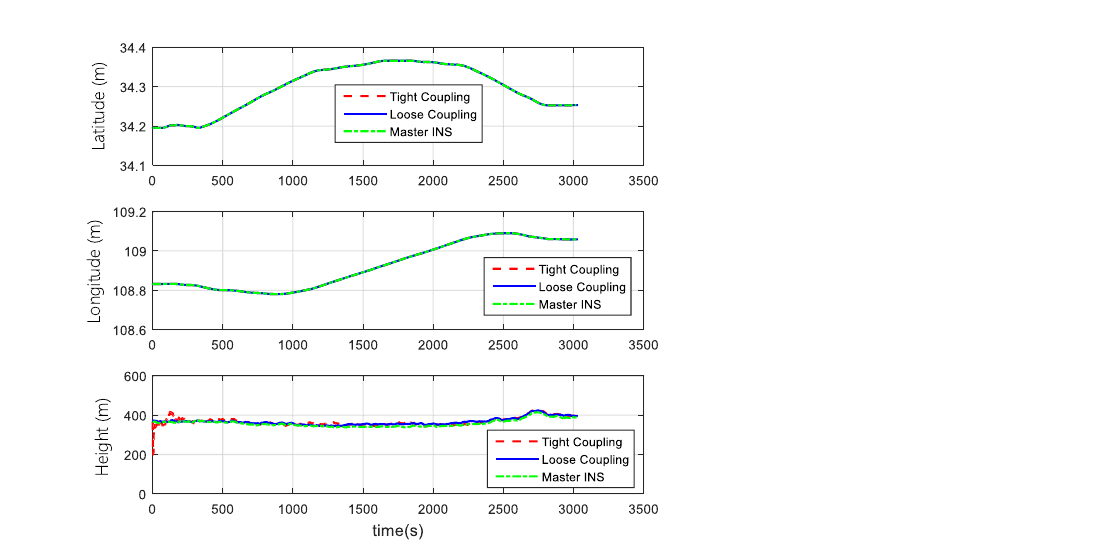
Figure 10. Position comparison of tight and loose